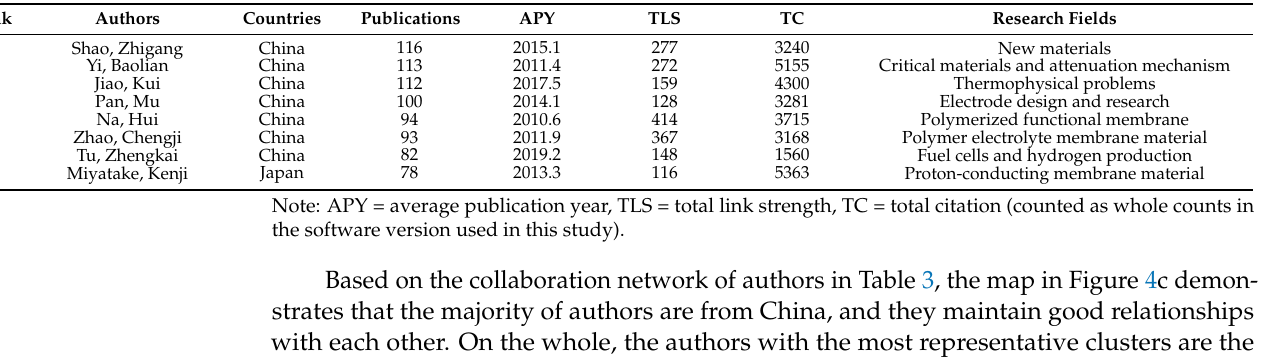
Table 3. Publication information of authors in PEMFC